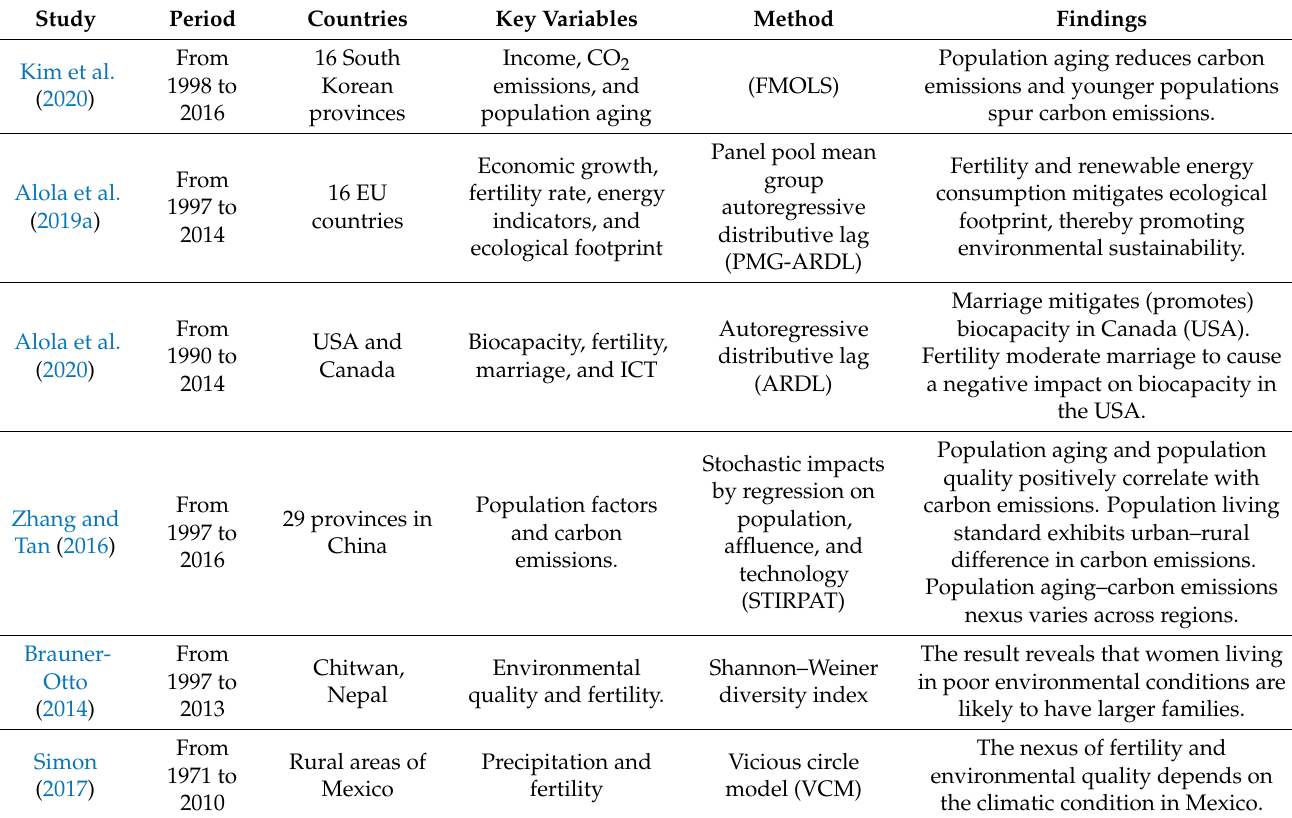
Table 2. Summary of related studies on fertility rate and environmental